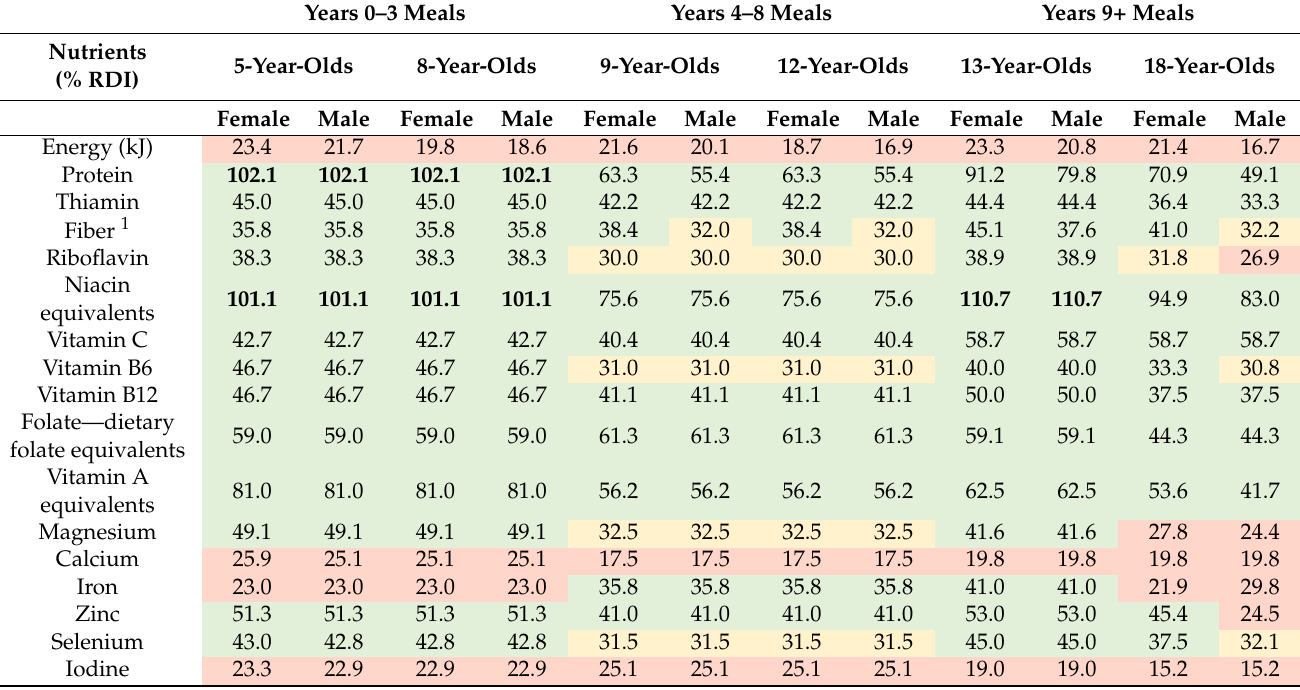
Table 4. Median nutrient levels as a percentage of